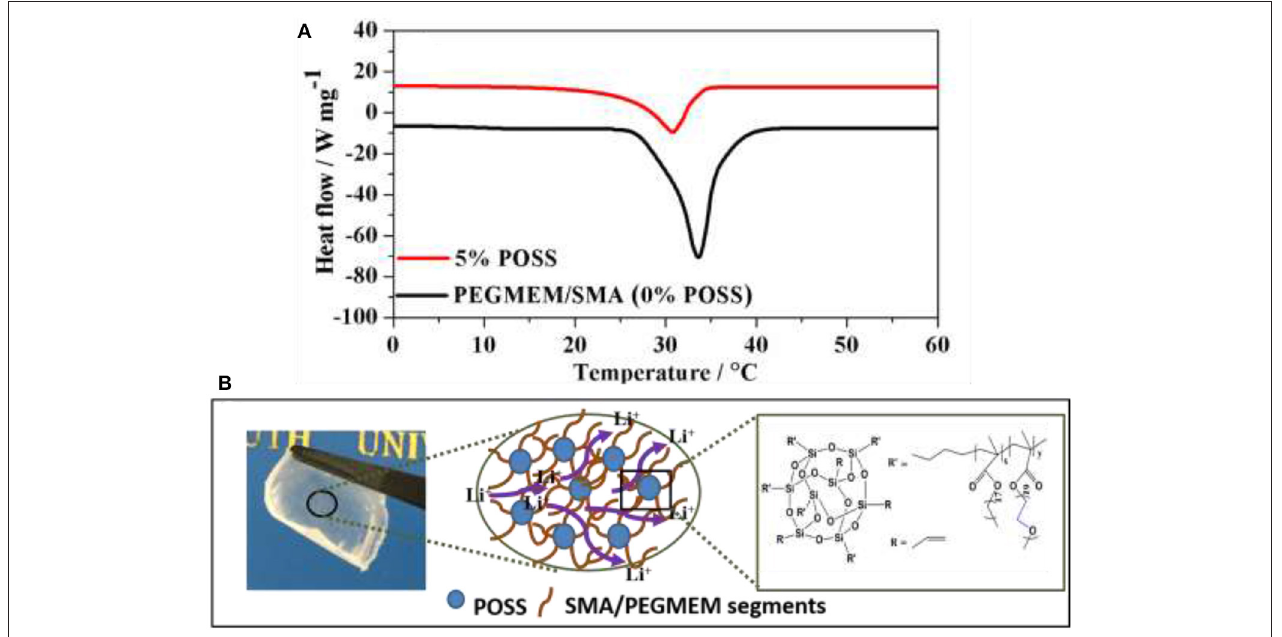
FIGURE 7 | Polarization test for Li/Li symmetric battery with a constant current density of 0.1 and 0.2mA cm − 2 at 25 and 80 ◦ C.